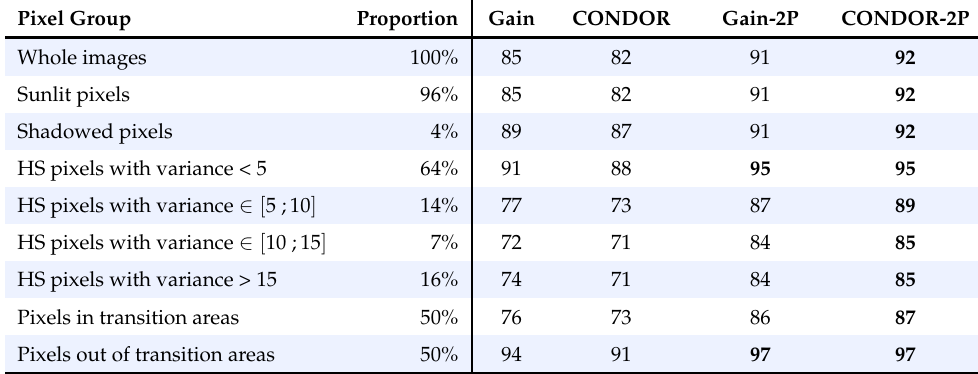
Table 4. “Toulon” peri-urban dataset: overall accuracy values (in %) for different pixel groups (depicted in Figure 13).